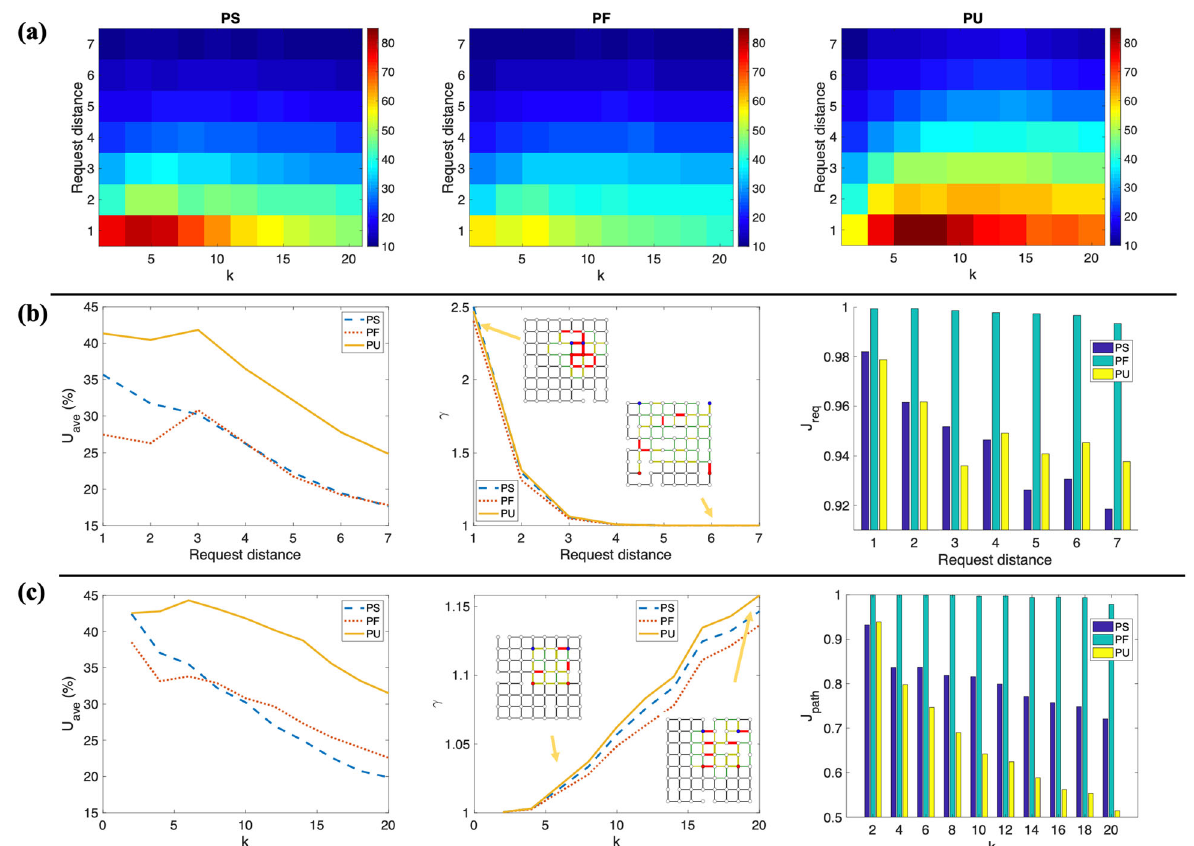
Fig. 5 Algorithm performance as a function of number of shortest paths k and request distance. a Heat map of the throughput F for the two requests. b Routing performance with respect to request distance at k = 10. U ave , γ , and J req plots are shown here. c Routing performance with respect to k at request distance 3. U ave , γ , and J path plots are shown here. Examples of traf fi c plots with different parameters for the PU algorithm are shown in the inset of γ plots. The other system parameters are { l max , α , β } = {15, 1,